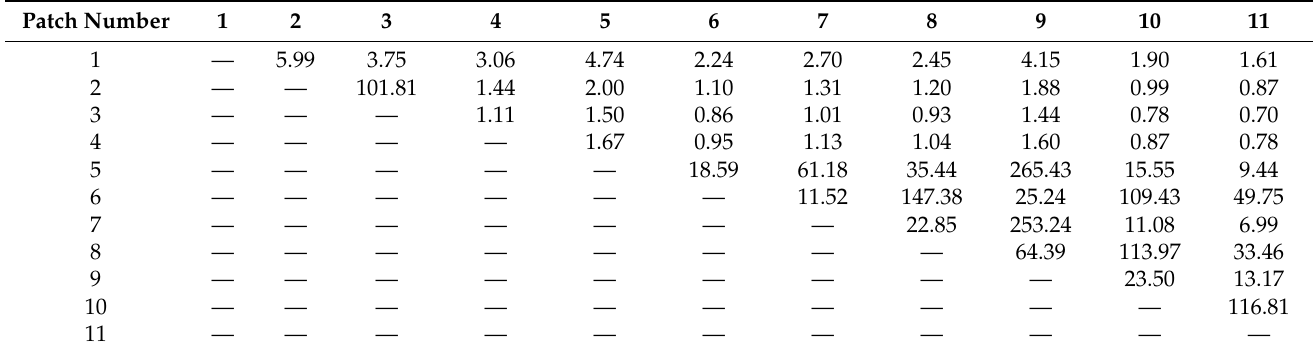
Table 6. Ecological interaction force matrix.